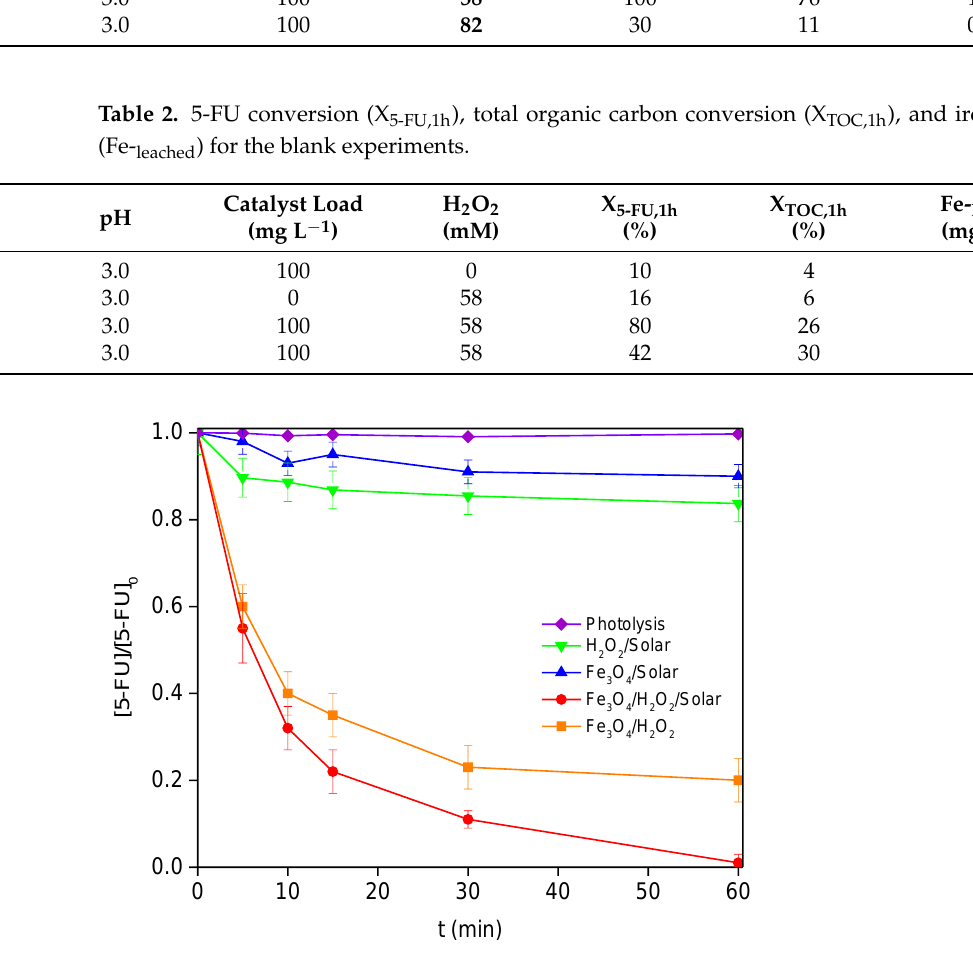
Table 1. Different experimental conditions used in the solar photo-Fenton experiments for the 5-FU degradation and respective Fe-leached and TOC conversion after 1 h of reaction.